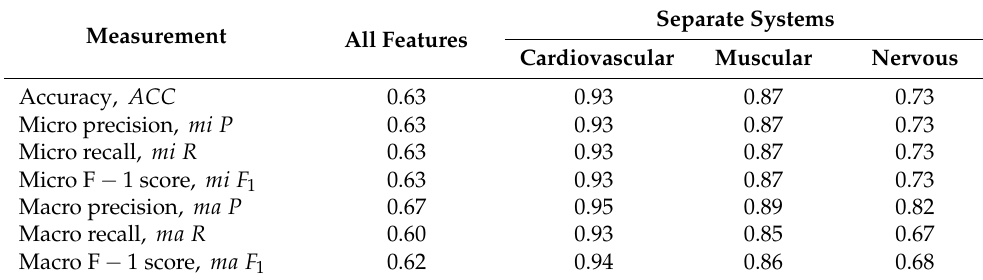
Table 6. Averaged RF model accuracy, precision, recall, and F 1 scores.